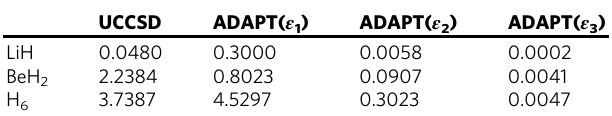
Table 1 Average errors across the PES scan for the different methods assessed. Units in kcal/mol